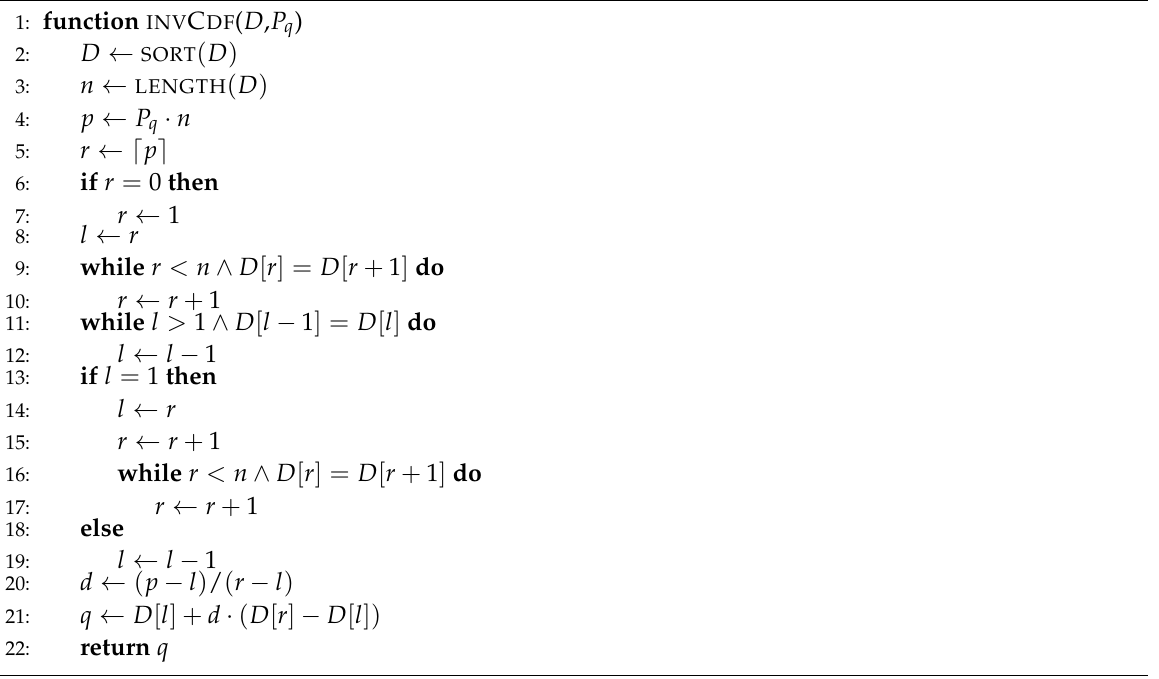
Algorithm 2 Inverse cumulative distribution function